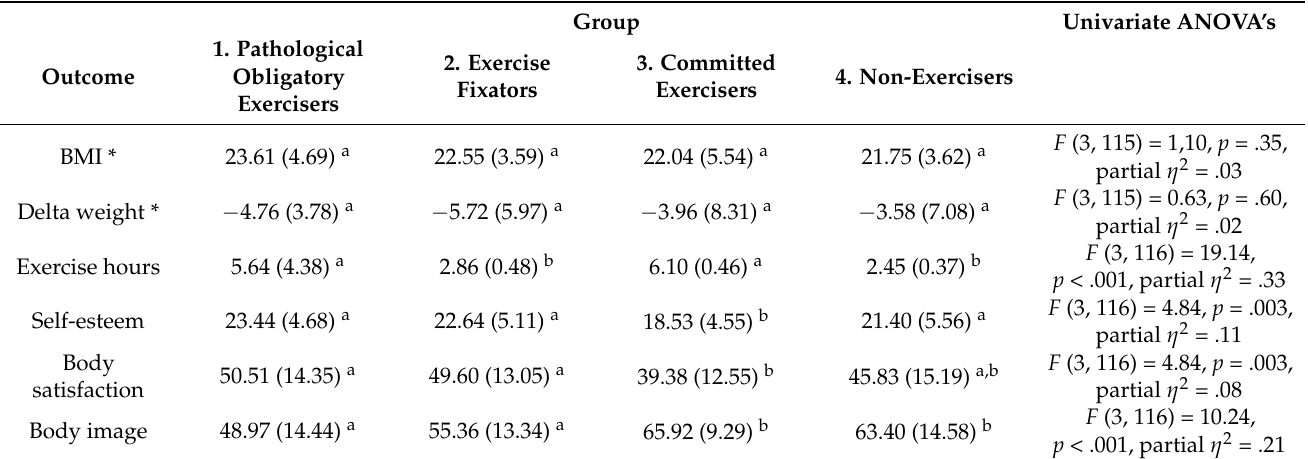
Table 3. Mean scores, Standard Deviations (SDs) and test results (including simple effects). Group Univariate